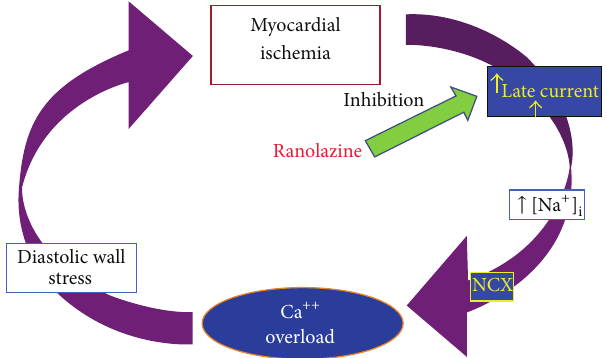
Figure 6: Mechanism of action of ranolazine. The pharmacologi- cally induced reduction of the late sodium current ameliorates the myocardial diastolic relaxation by reducing the diastolic wall stress. This finally produces an improvement of segmental myocardial